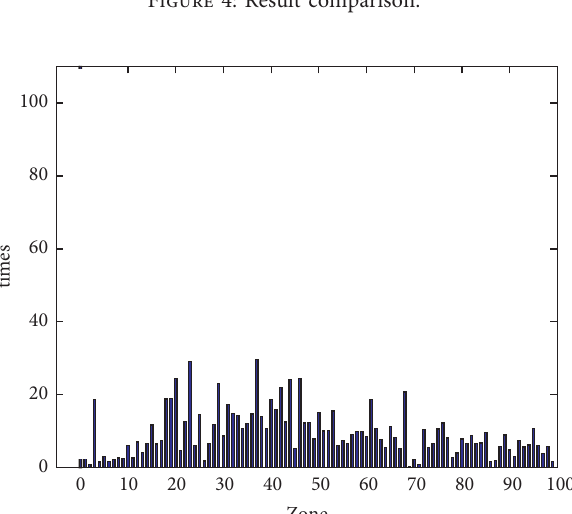
Figure 4: Result comparison.